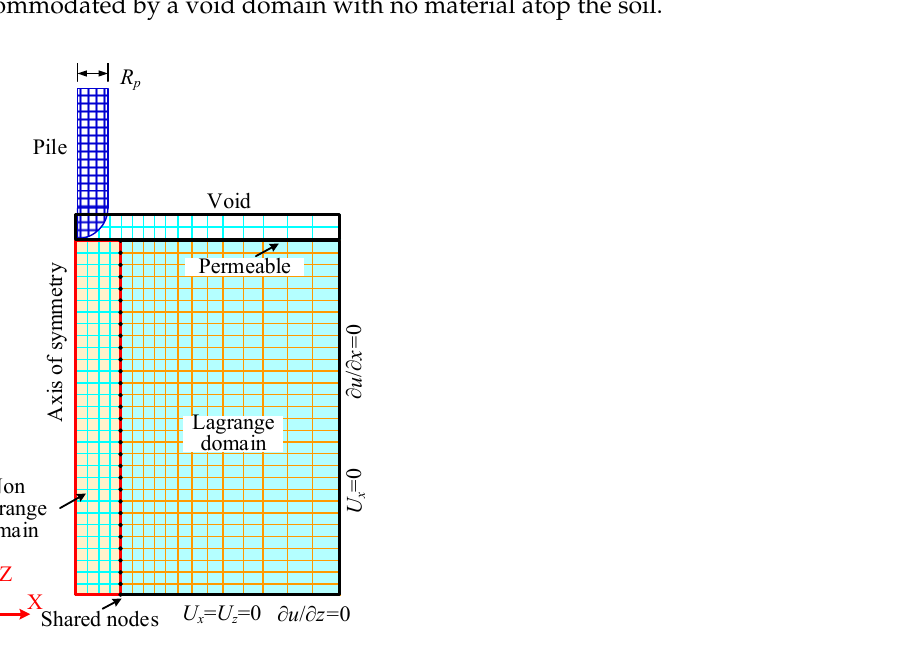
Figure 2. Schematic diagram of finite element model based on the hybrid Lagrangian–ALE ap- proach.